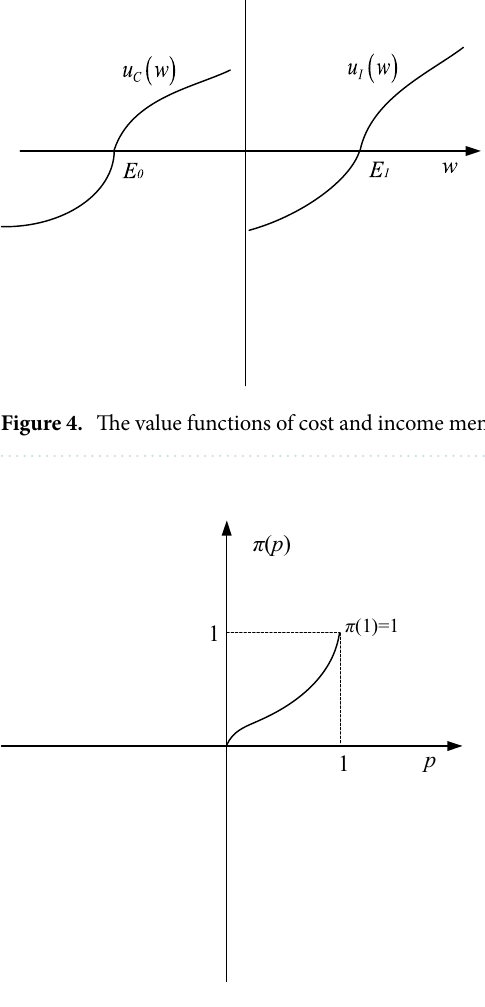
Figure 5. The weigh function of mental